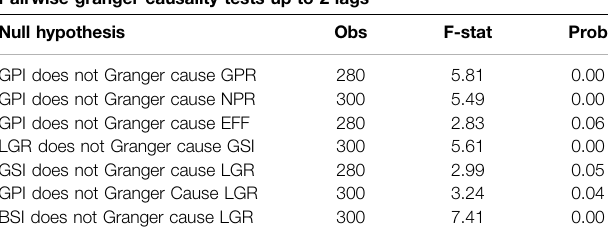
TABLE 2 | Granger causality